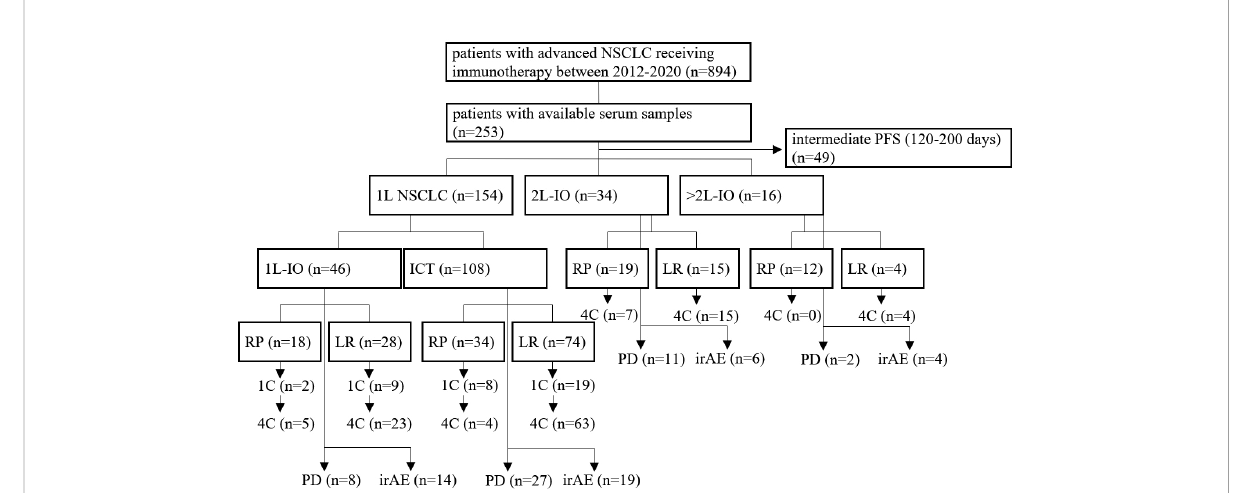
FIGURE 1 Flowchart of study patients. A total of 894 patients with metastatic NSCLC from 2012-2020 was treated with immunotherapy (IO), i.e. either PD-(L)1 inhibitors alone or in combination with chemotherapy (ICT), of which serum samples were available for 253. This study focused on patients with either rapid progression (RP, i.e. within 120 days from immunotherapy start), or long-term bene fi t (LR, i.e. progression-free survival > 200 days), as explained in the Materials and Methods . Treatment was either in the fi rst (1L) or in the second and subsequent lines (2+L IO). Samples were collected at baseline, after 1 cycle of treatment (1C), after 4 cycles of treatment (4C), or at the time of disease progression (PD), as possible. Some patients developed immune-related adverse-events (irAE), which were analyzed